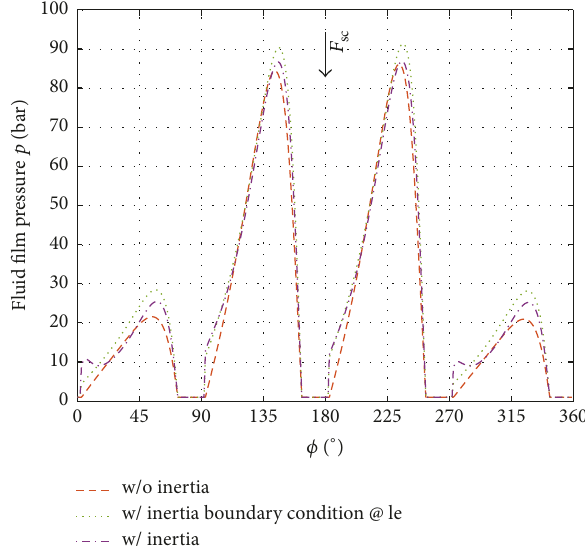
∘ C, 𝑧 = 36 mm, and sup = 50